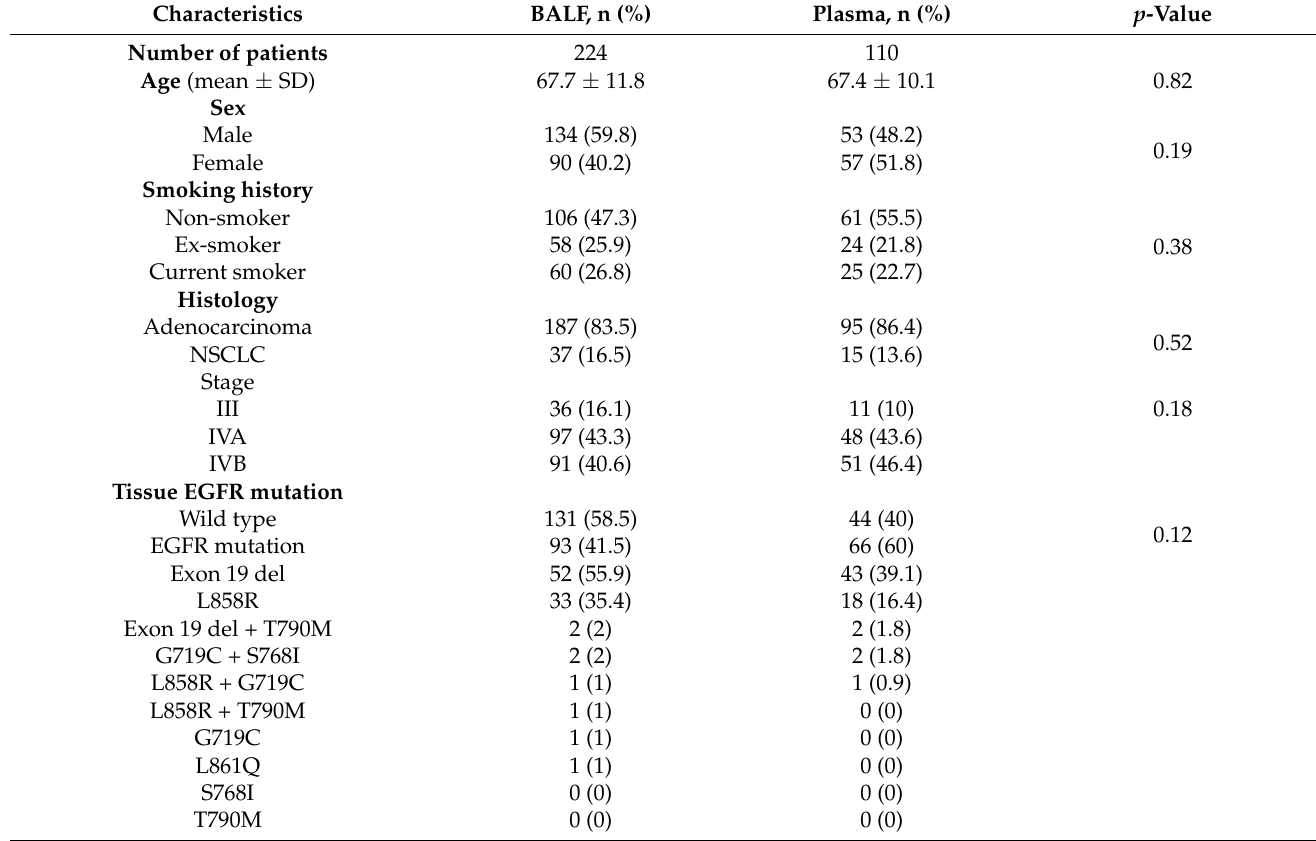
Table 1. Patient demographics and clinical